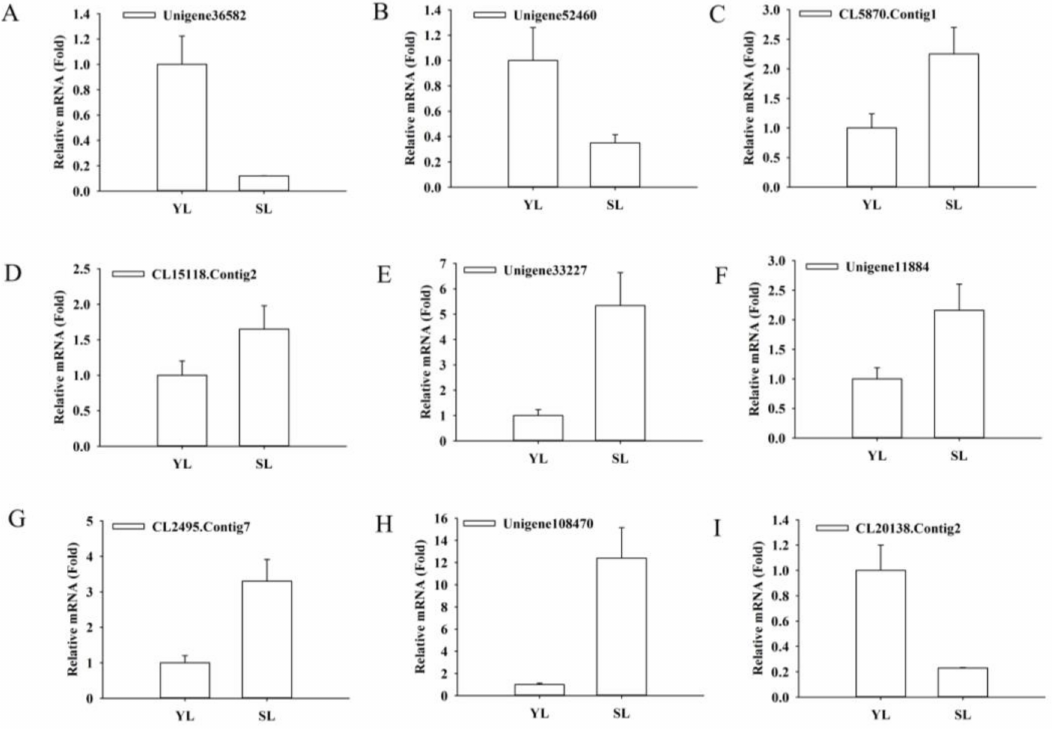
Figure 6. Expression patterns of selected unigenes related to transcription factors identified by RNA-Seq were validated by qRT-PCR. Expressions of unigenes, homologs to AtMYB12 ( A ) Unigene36582 and ( B ) Unigene52460 , homologs to VvMYB75 ( C ) CL5870.Contig1 , homologs to VvMYB1R1 ( D ) CL15118.Contig2 , homologs to AtbHLH113 ( E ) Unigene33227 and ( F ) Unigene11884 ,